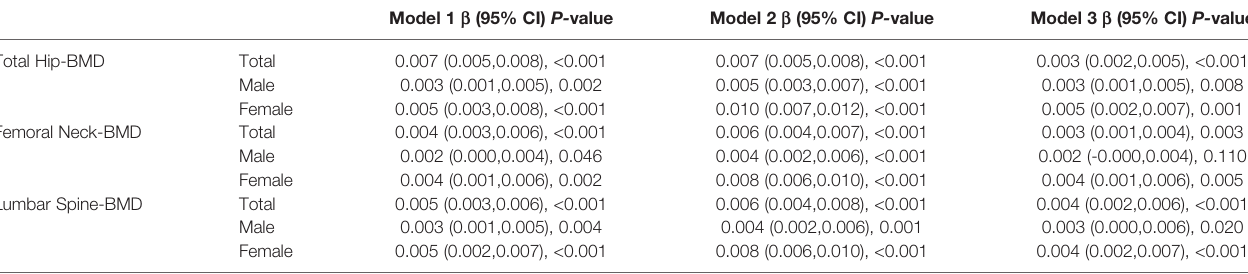
TABLE 3 | Associations between fasting plasma glucose and BMD